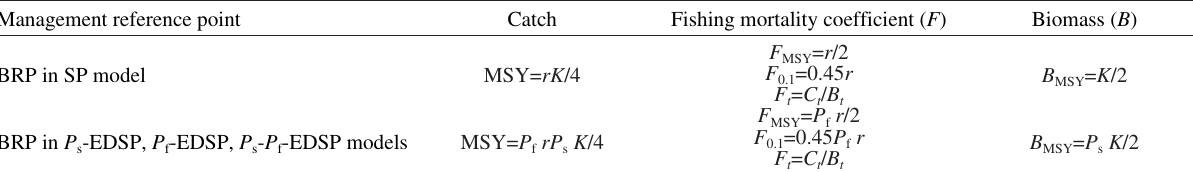
Table 1. – The fishery management reference points of O. bartramii in the northwest Pacific Ocean. BRP, biological reference point; SP, surplus production; EDSP, environmentally dependent surplus production models; P , proportion of favourable spawning habitat areas with s sea surface temperature of 21-25°C; P , proportion of favourable feeding habitat areas with different sea surface temperature ranges in differ- f ent months; MSY, maximum sustainable yield. Note: C is the catch in year t and B is the biomass in year t t t